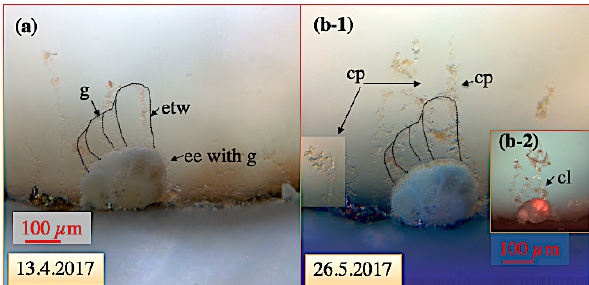
Figure 8. Crescent-shaped ectoplasmic twigs of C. pachyderma specimen 1 positioned at the hole of the sinter ring, i.e. at the inflow of water and algal food into this aquarium. (a) Specimen viewed under normal light when no food was added to the inflow revealing bow-like ectoplasmic twigs. (b) Thirty-five days later, the pumps were stopped 1 to investigate the stability of the ectoplasmic twigs and the pseudopodial network at zero current activity but stable high-pressure conditions. Stable ectoplasmic twigs and collapsed pseudopodial (cp) network under normal light (b-1) and fluorescent light (b-2) . The red colour of especially older test parts results from ingested Spirulina and Chlorella algae stored in food vacuoles of the cytoplasm. “ee” denotes ectoplasmic envelope; “etw” denotes ectoplasmic twig; “g” denotes granule; “cl” denotes calcein-stained cytoplasmic lacuna in the etw and cp. 1 A shut-off valve following downstream the overflow valve prohibited a pressure drop in the high-pressure aquaria when the pumps were shut.